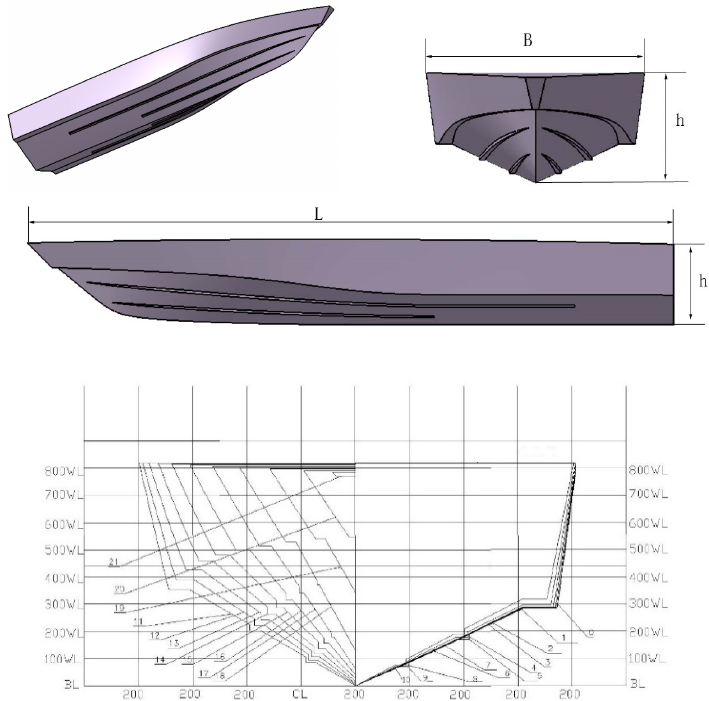
Table 9. Model parameters of the improved vessel.